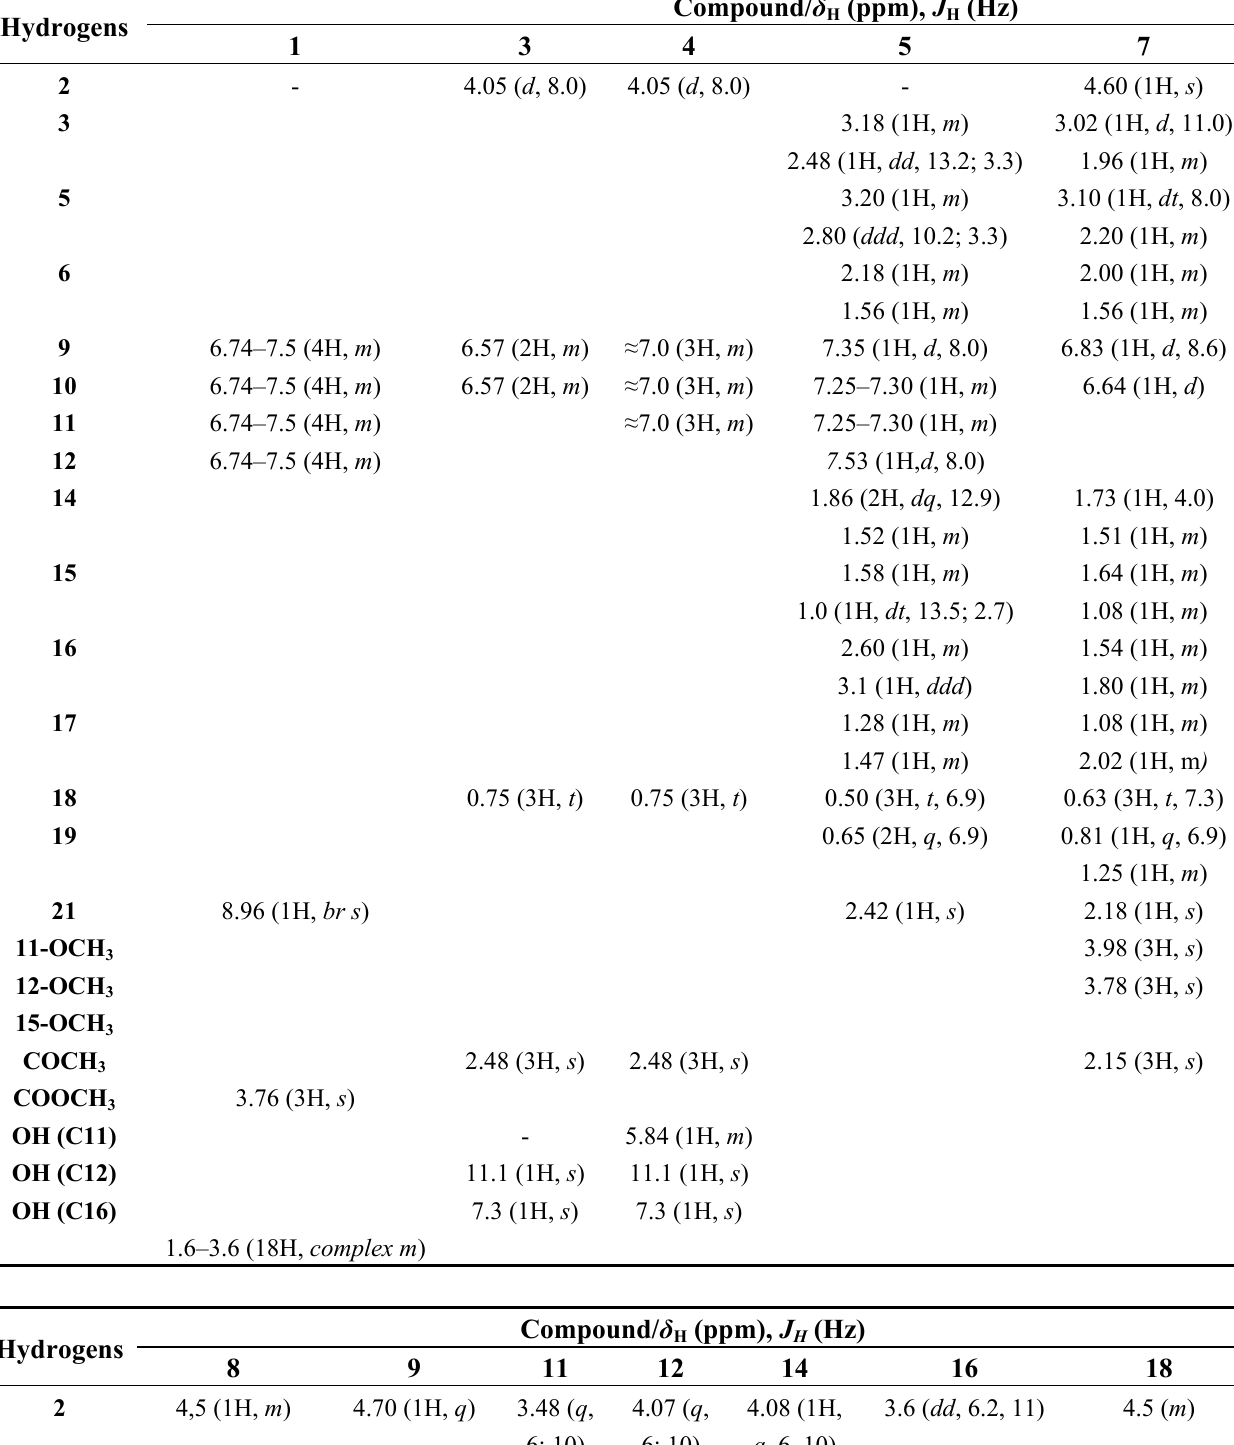
Table 2. 1 H-NMR data (in CDCl species. (Multiplicities, J , in